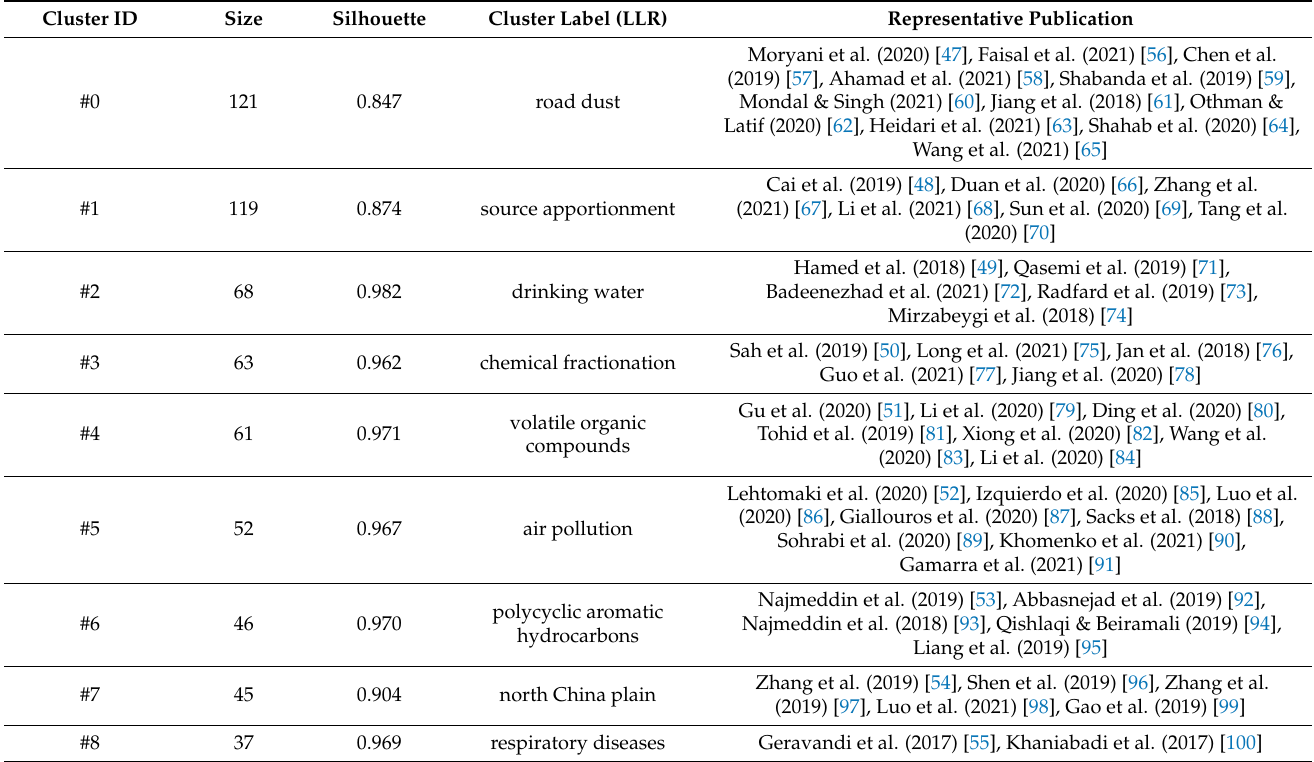
Table 7. Summary of the largest nine clusters in